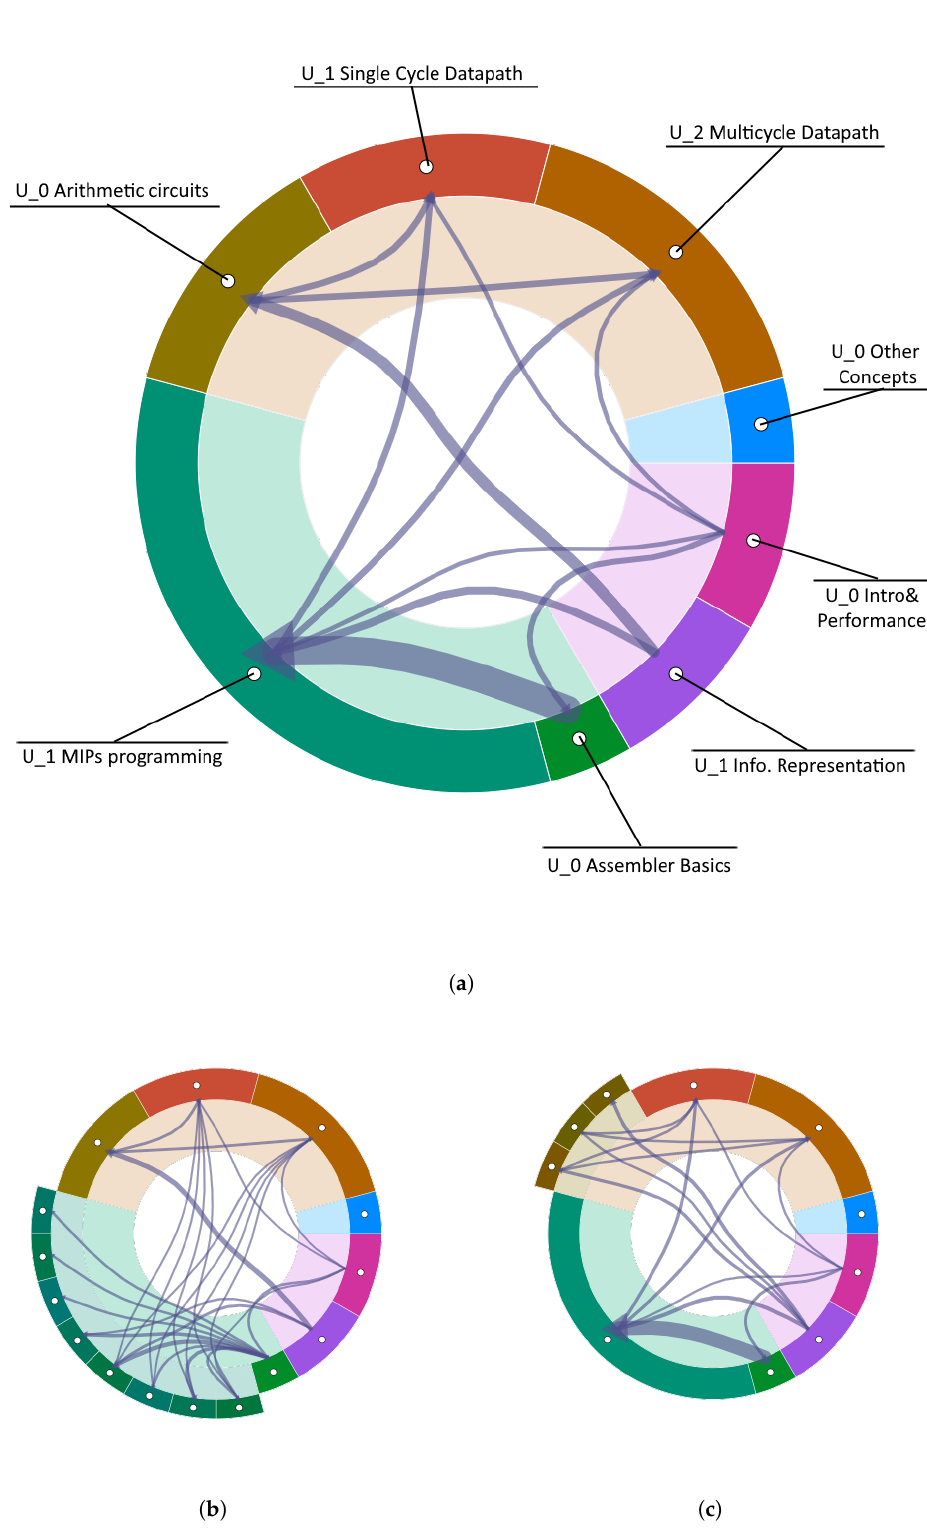
Figure 21. ( a ) Unit level. Hierarchy of contents collapsed at the unit level. ( b ) MIPS Prog. Unit. MIPS Programming Unit uncollapsed at lessons level. ( c ) Arith. Circuits Unit. Arithmetic Circuits Unit uncollapsed at lessons